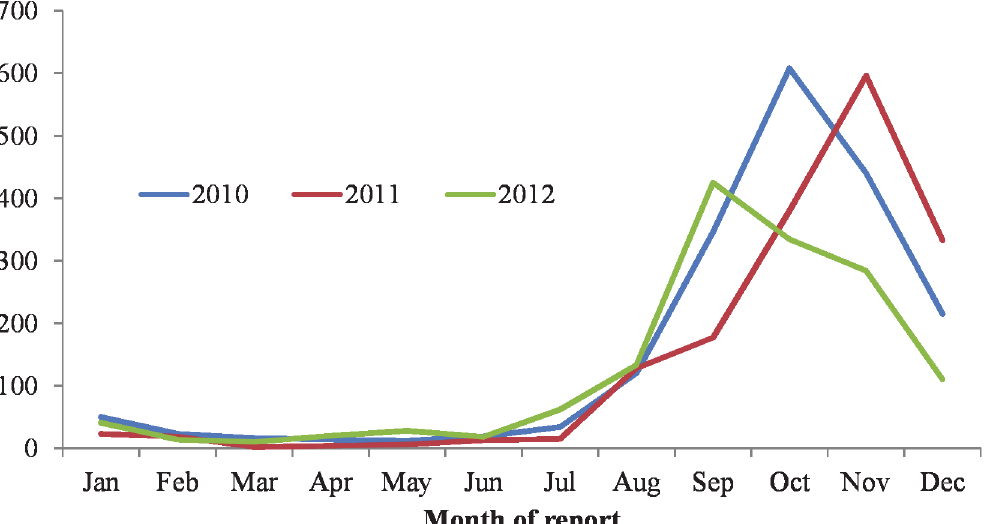
Fig 2. Number of confirmed cases of dengue fever reported to the National Disease Surveillance System by month of report, Taiwan, 2010 – 2012.